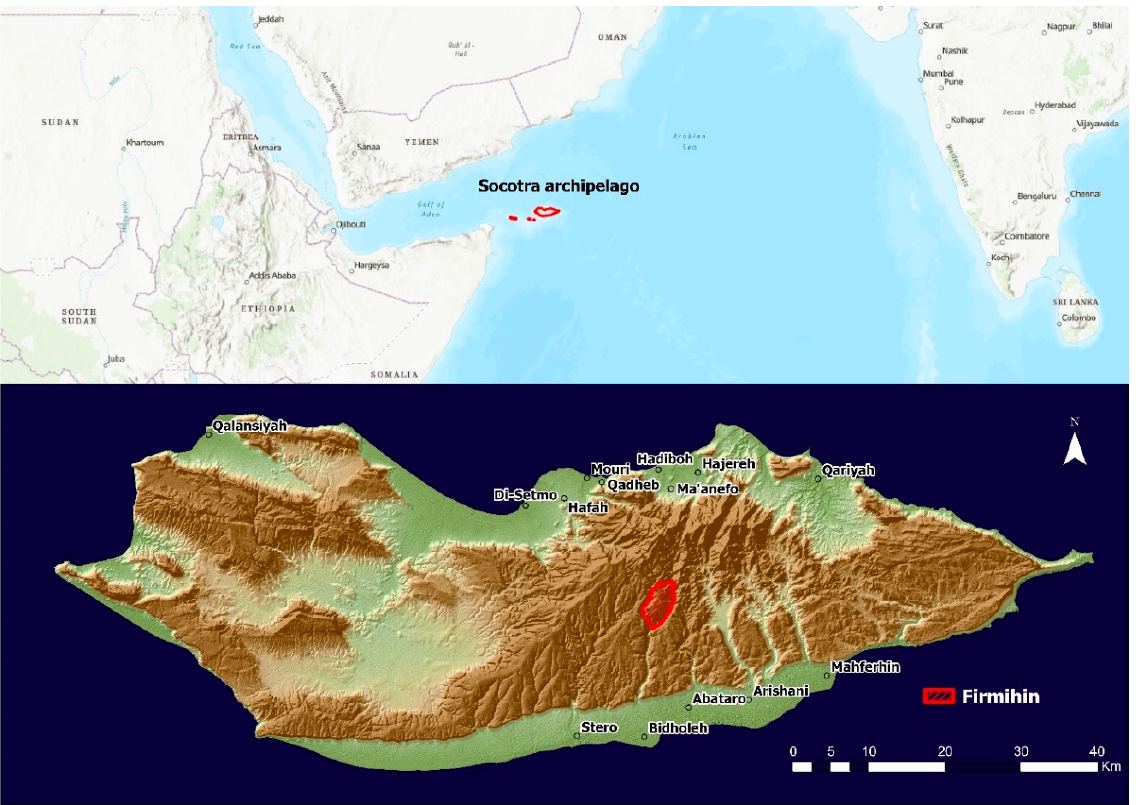
Figure 1. The Socotra Archipelago (Yemen) ( up ) and location of the Firmihin Plateau (in red) in Socotra Island ( below ).